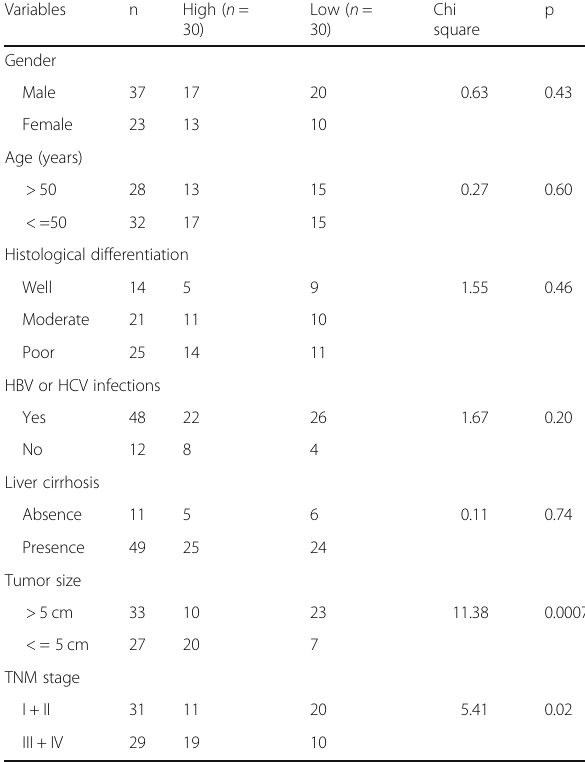
Table 1 Correlation between levels of TINCR expression levels in HCC and patients ’ clinical